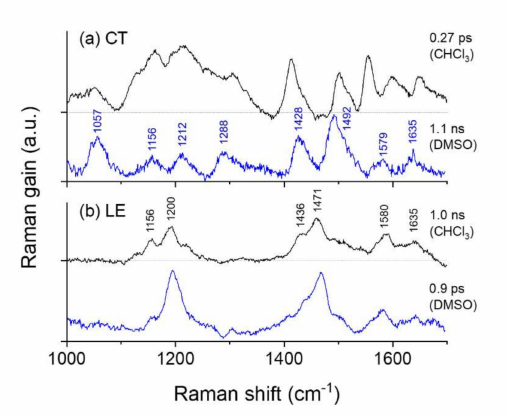
Figure 4. Evolution associated di ff erence spectra (EADS) for ( a ) the intramolecular charge transfer (ICT) and ( b ) locally-excited (LE) state of DCM in CHCl 3 and DMSO solution with the specific time constants. The kinetic information obtained from the global analysis over all the vibrational modes can be slightly di ff erent from the kinetics of a specific vibrational